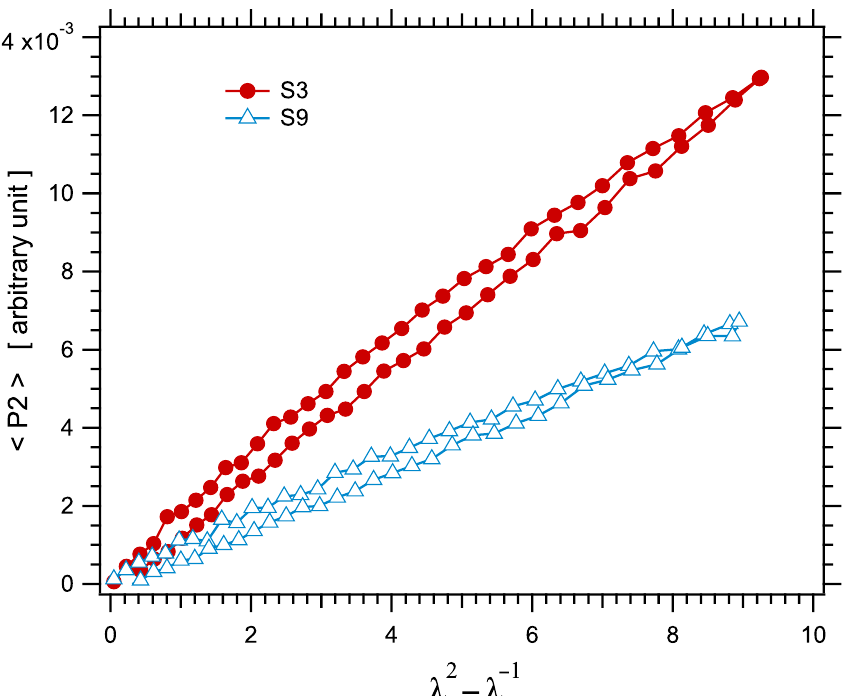
Figure 12. Segmental orientation parameter P 2 measured along stress–strain cycles in two representa- tive samples S3 and